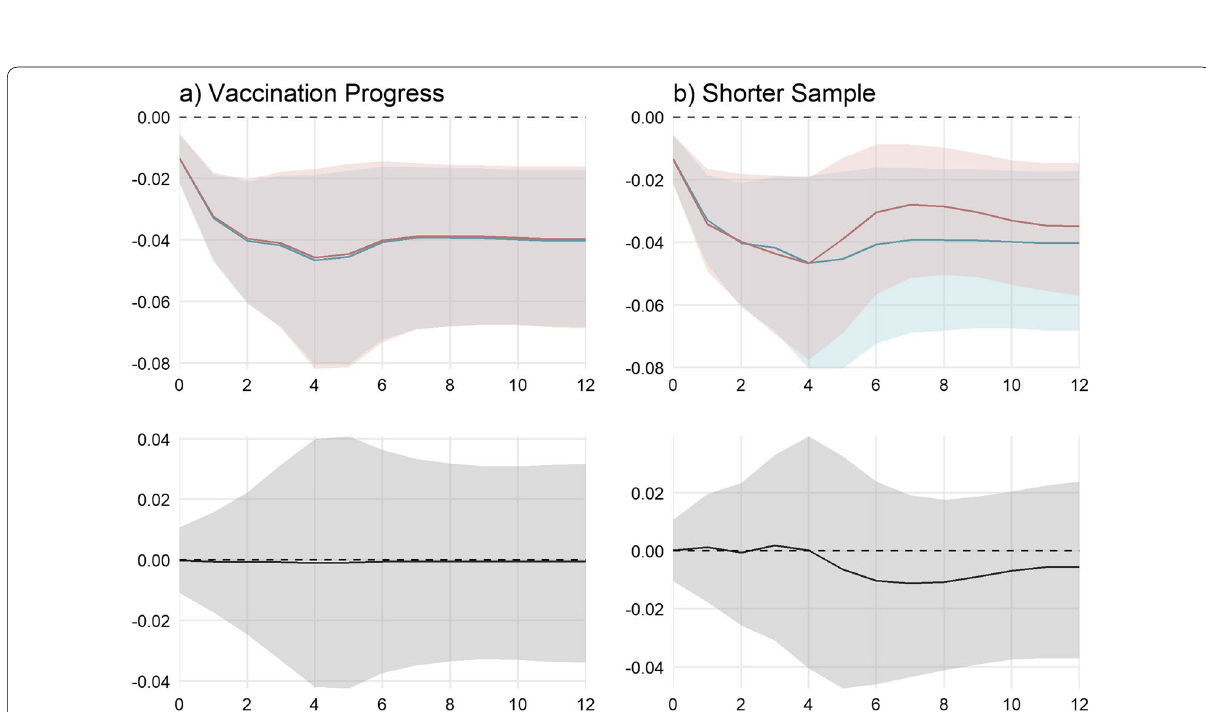
Fig. 15 Cumulative impulse responses of infection growth I to policy P for two alternative models. The impulse responses are estimated using the ln R e with canton and time fixed effects. The top panel shows 3 and P (cid:31) KSI + , B (cid:31) lnNTRX , and I recursively ordered VAR(4) in (4) with k = = = = the cumulative IRs of Infection Growth I to Policy P of the baseline model (blue) and the alternative specification (red). The bottom panel shows the difference between the baseline and alternative IRs. The alternative models are characterized by: a two additional control variables concerning vaccination, namely the (lagged) change in the number of fully as well as partially vaccinated residents (left), and b a shorter sample length (right). Both variants do not include the interaction terms on vaccination progress. The data span from September 28, 2020, until April 18, 2021 for model ( a ), and until January 17, 2021 for model ( b ). The shaded areas represent 95% confidence intervals based on a wild bootstrap procedure with 5000 repetitions. The horizontal axes depict the time horizon in weeks. The vertical axes are shown in units of